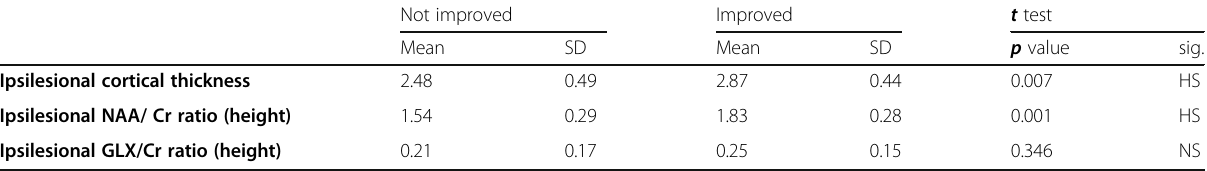
Table 2 Comparison in ipsilesional (cortical thickness and metabolite ratios) between the two study groups Not improved